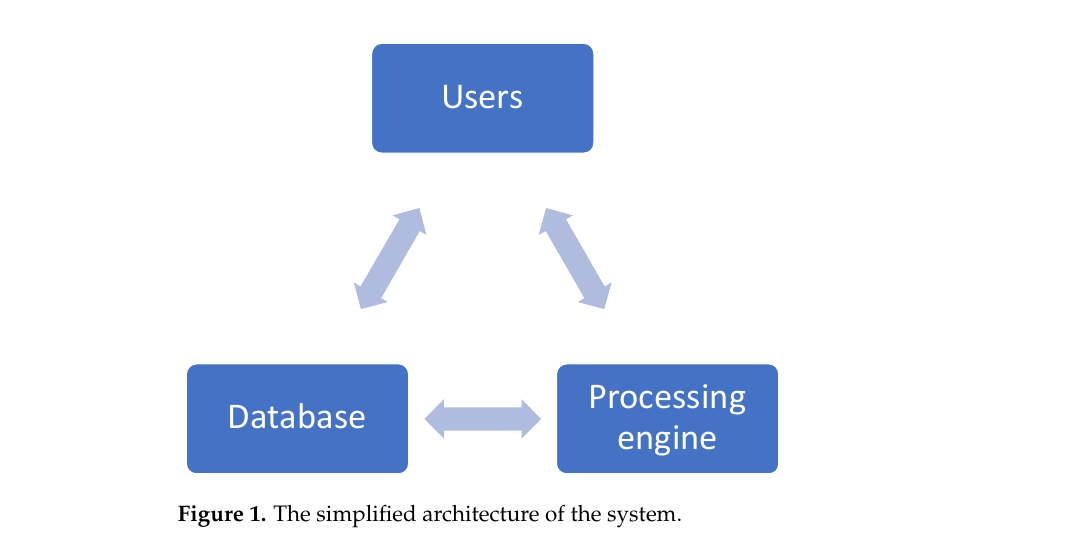
Figure 1. The simplified architecture of the system.